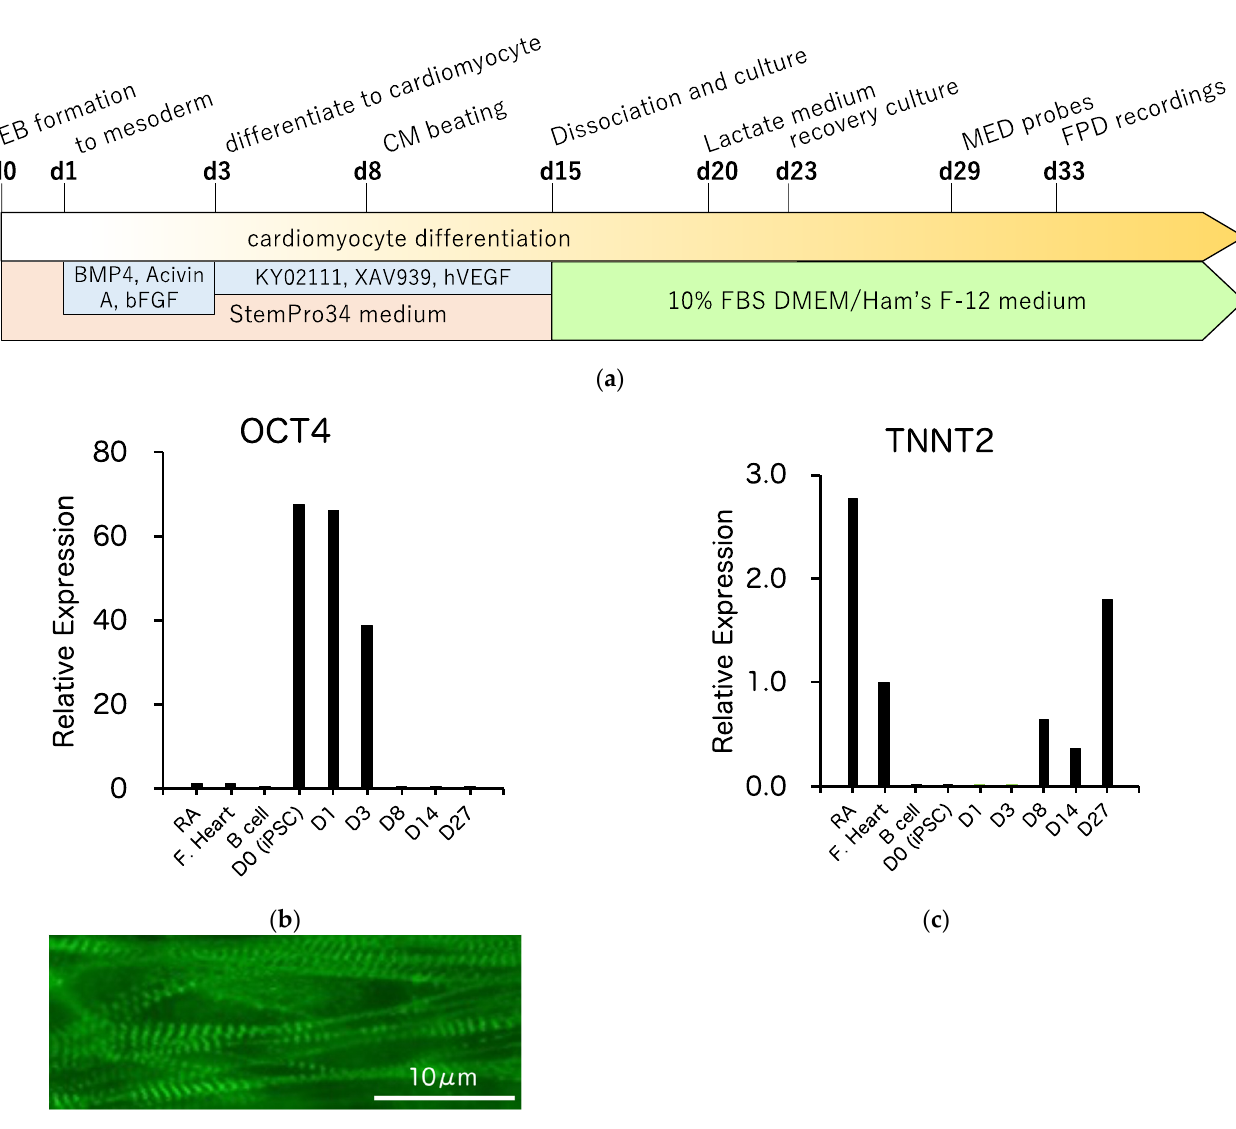
Figure 3. Cardiomyocyte differentiation from induced pluripotent stem cells (iPSCs). ( a ) Schedule of cardiomyocytes differentiation from iPSCs. EB: embryoid body, BMP4: bone morphogenetic protein 4, hVEGF: human vascular endothelial growth factor. Expression of pluripotency-associated ( b ) and cardiac markers ( c ) in differentiated cardiomyocytes. RA: adult right atrium, F. Heart: fetal total heart. ( d ) Immunostaining analysis revealed the presence of the contractile protein α -actinin in the cardiomyocyte derived from iPSCs. Scale bar = 10 μ m.